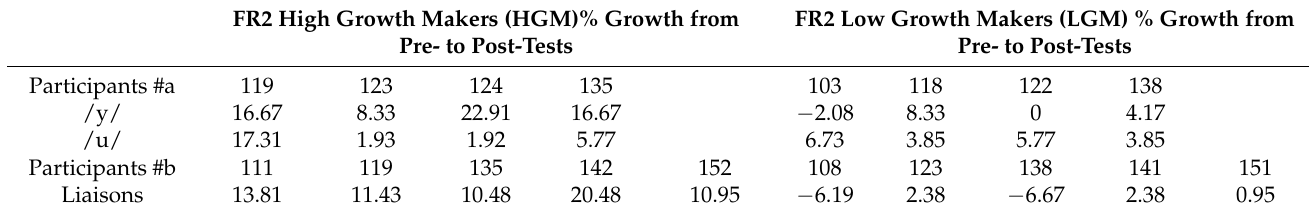
Table 7. Participants’ pronunciation growth from pre–post-tests in FR2.